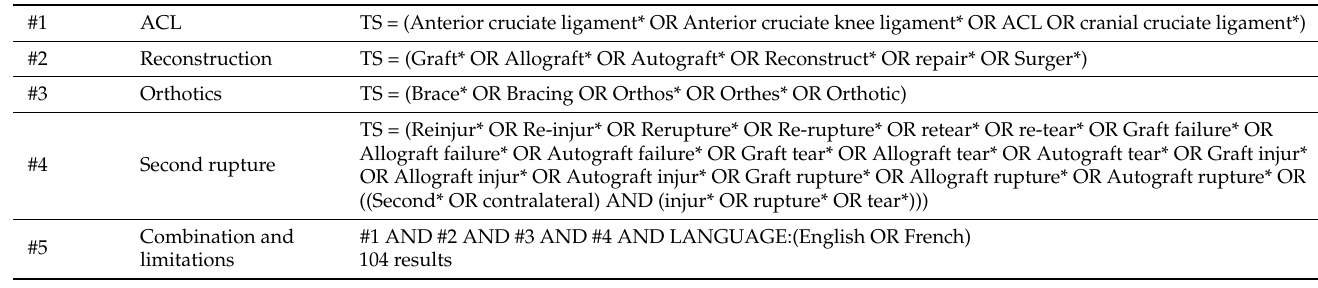
Table A6. ISI Web of Science 9 June